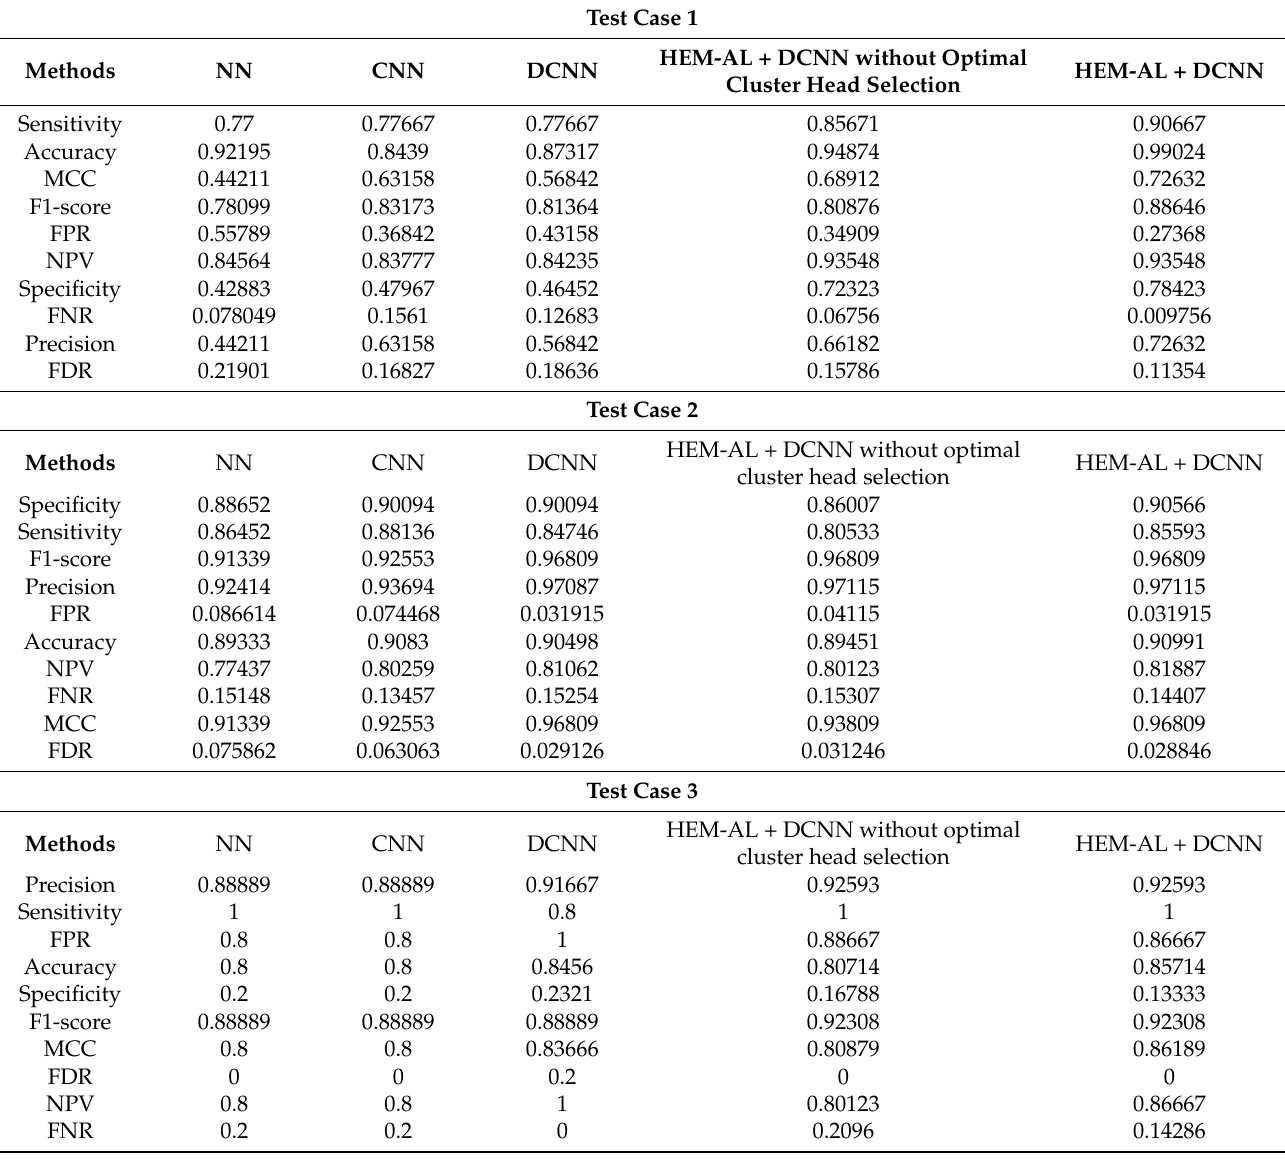
Table 2. Classification Performance of the adopted model and existing models for varied test cases. Test Case